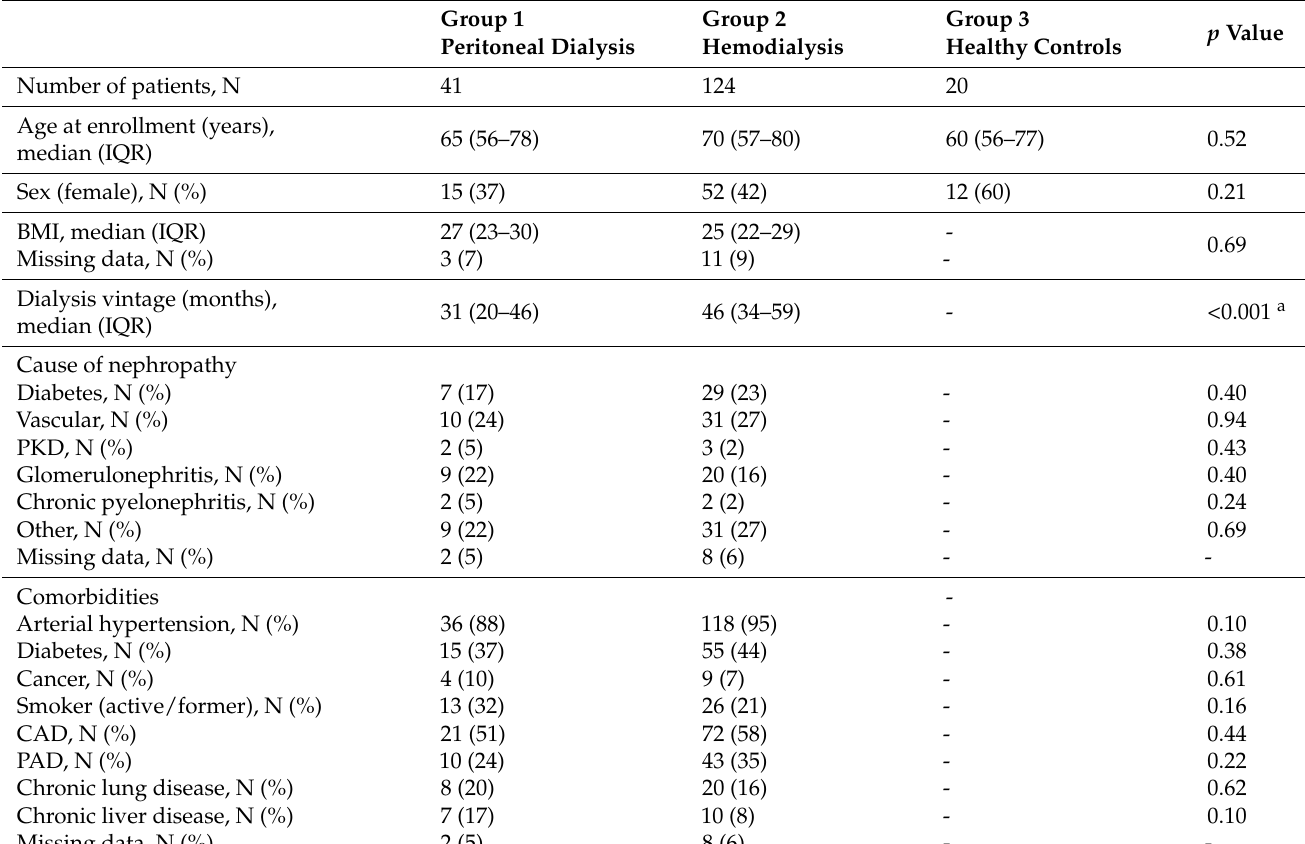
Table 1. Participants’ baseline